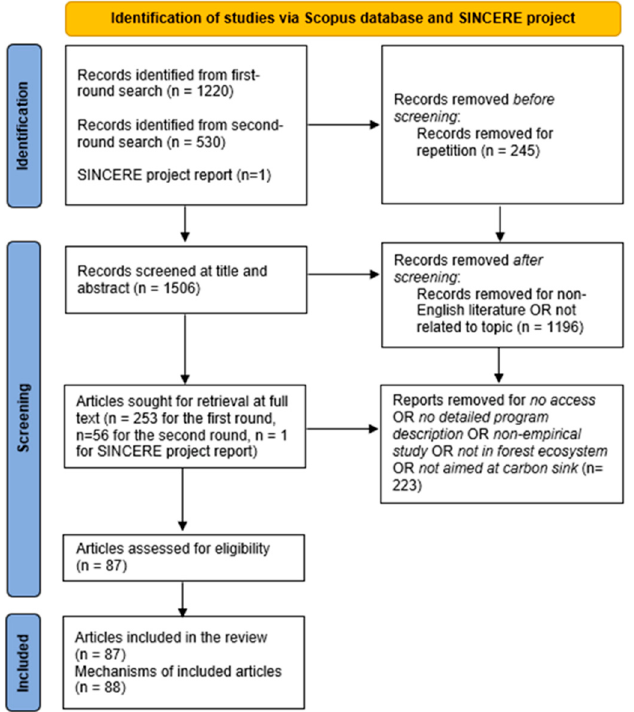
Figure 1. Diagram of systematic literature review (adapted from Page et al. [30] and Maier et al.